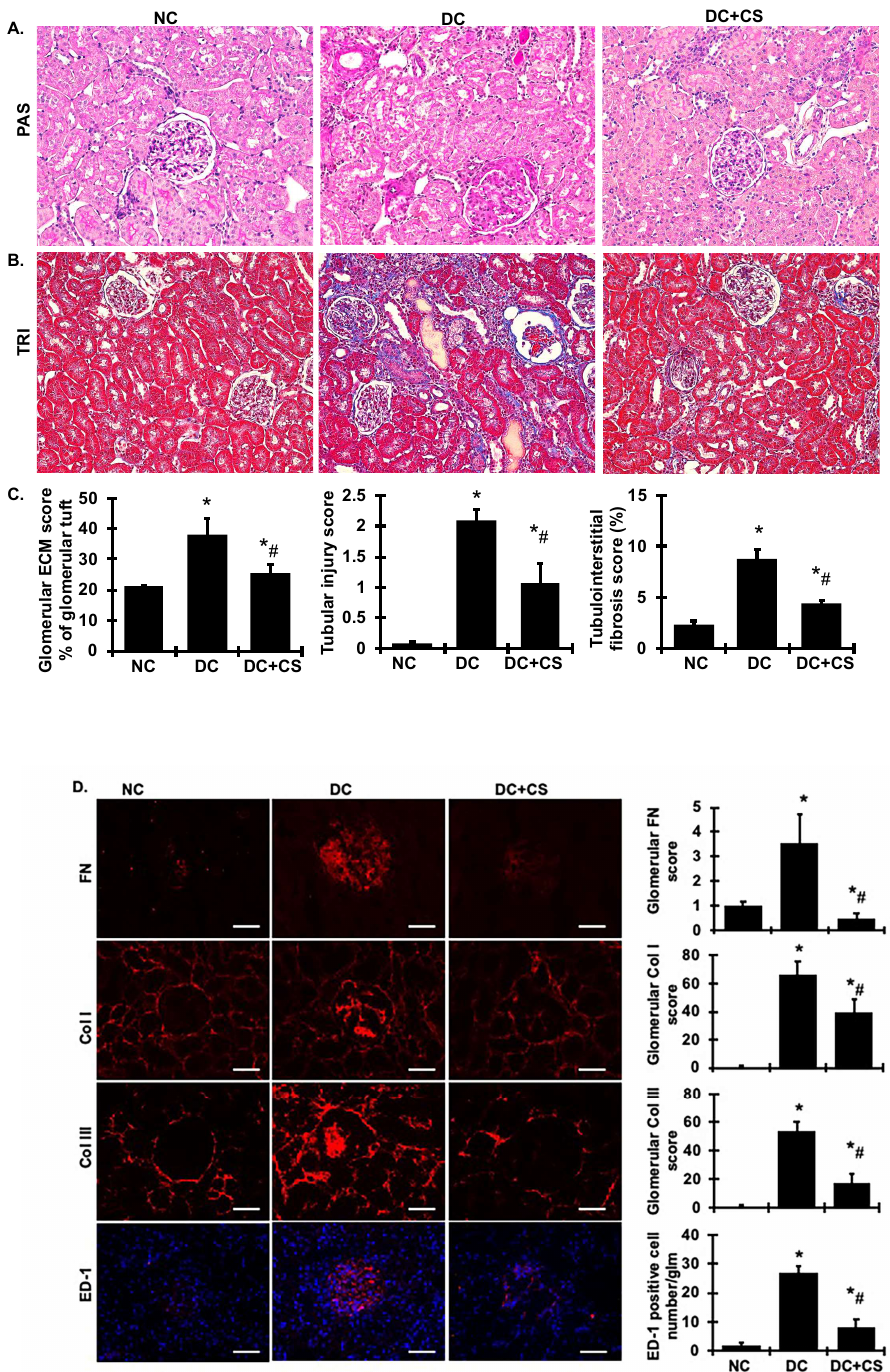
Figure 4. rBMSC sheets reduce glomerulosclerosis, tubular injury, tubulointerstitial fibrosis, and glomerular macrophages infiltration in CGN rats. ( A ) The histological renal sections stained with PAS showing glomerular ECM accumulation (stained pink) are presented at 200 × magnification. ( B ) Masson’s trichrome (TRI) staining of the kidney sections used to detect tubular injury, inflam- mation, and collagen deposition were viewed with bright field illumination at 200 × magnification. ( C ) The graphs summarize the results of the glomerular ECM staining score and tubular injury and tubular collagen deposition. ( D ) The immunofluorescent staining for renal sections for FN, Col I, Col III, and ED-1 positive macrophages. Scale bars represent 50 µ M. Graphic representations of glomerular staining score or number of macrophages are shown on the right. * vs. normal control rats (NC), p < 0.05; # vs. disease control rats DC, p < 0.05. DC + CS, diseased rats received rBMSC sheets